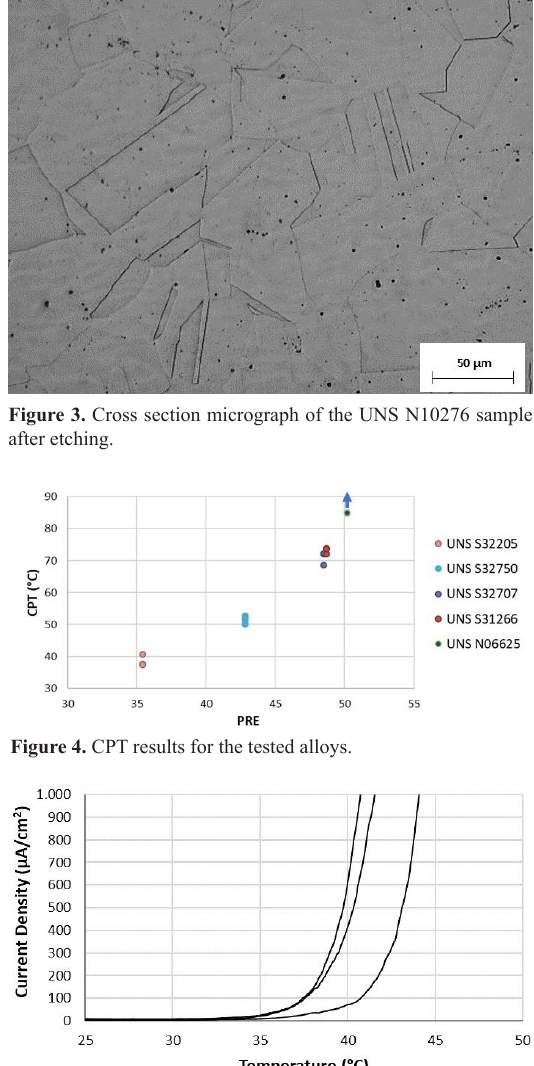
Figure 9. CPTs tests for UNS N06625 samples. Crevice corrosion occurrence represented in dotted lines.